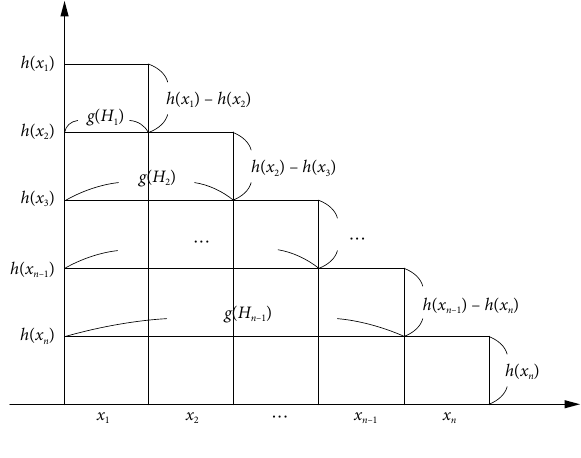
Fig. D1. Concept of fuzzy